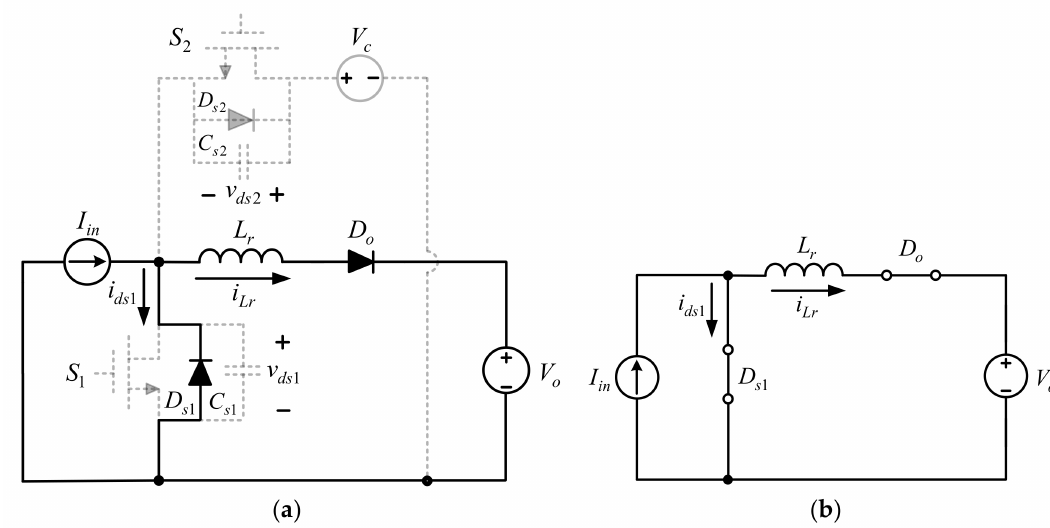
Figure 10. ( a ) Current path for stage 7; ( b ) equivalent of ( a